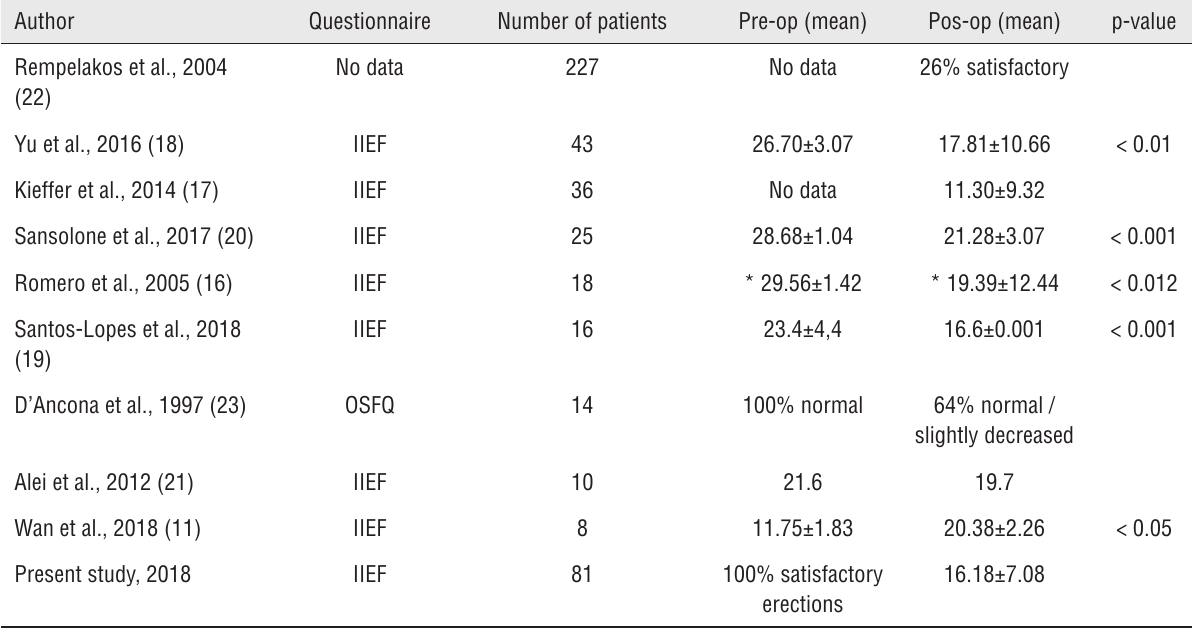
Table 3 - Erectile function after partial